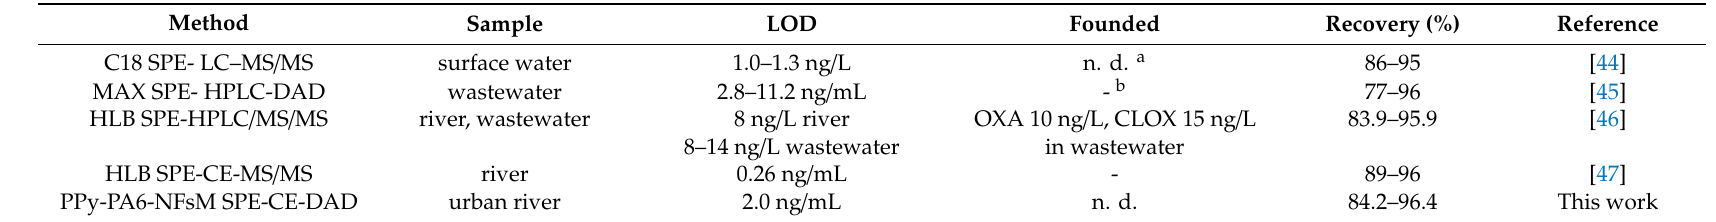
Table 2. Comparison of various method for the determination of the two β